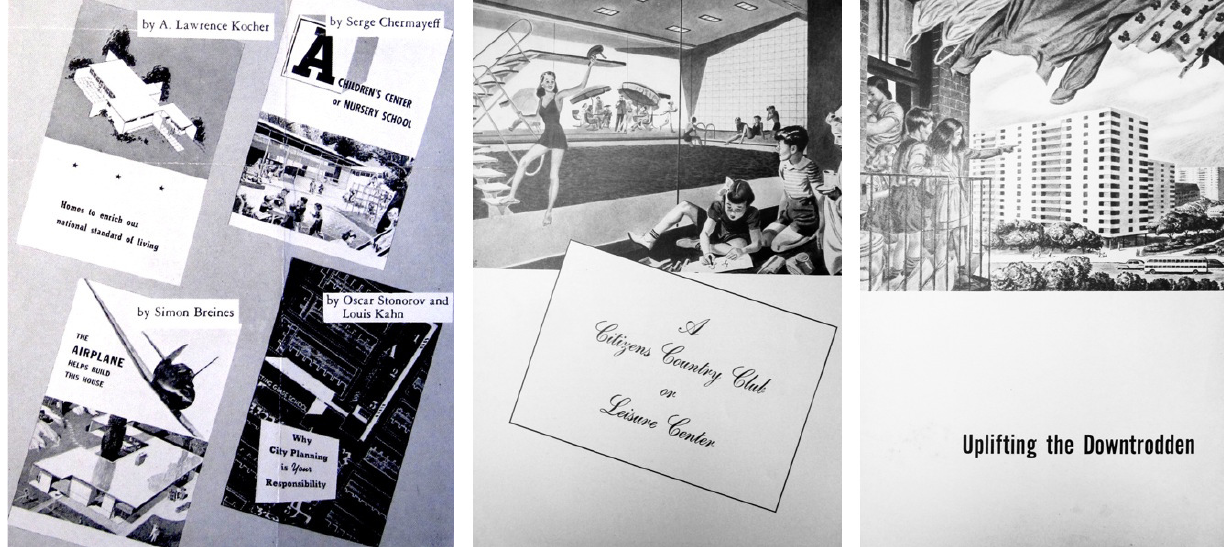
Figure 2. Advertisement of the booklets on “post‐victory community design” published by Revere Copper & Brass during WWII. Sources: Lescaze (1942 [center], 1944